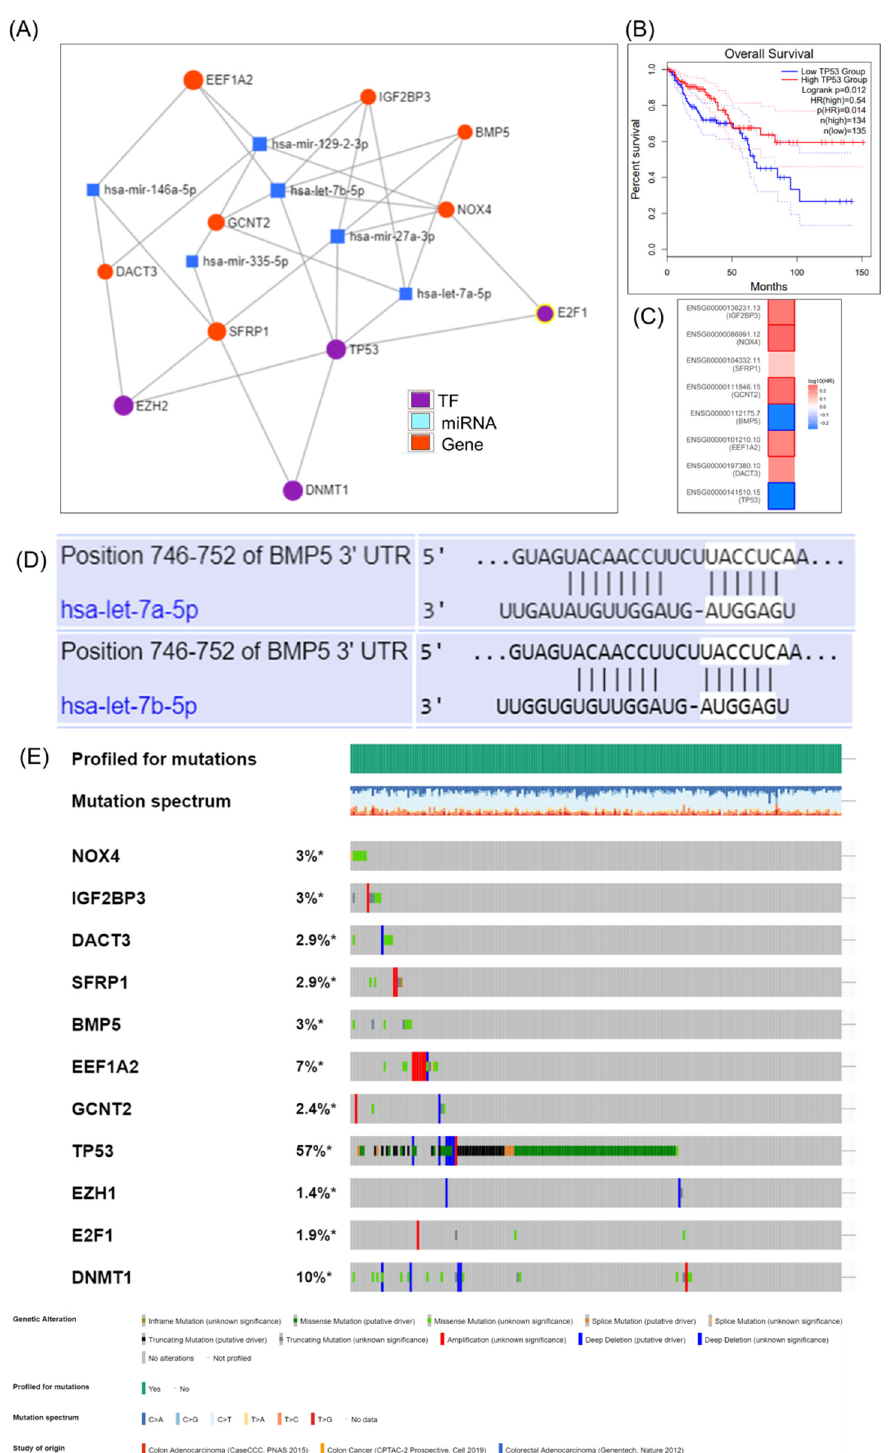
Figure 5. The target gene–miRNA interaction in COAD as revealed by the use of miRNET miRNA target gene online tool. ( A ) Interconnection between the EMT genes, key transcription factors and miRNA, generated using miRNET; ( B ) TP53 predicts overall survival rate in COAD; ( C ) survival map generated using GEPIA online tool; ( D ) prediction of has-let-7a-5p and let-7b-5p binding to BMP5 3 ′ UTRs, generated using TargetScan 3.0 (http://www.targetscan.org/mamm_30/docs/help.html, accessed on 22 April 2021); ( E ) analysis of genetic alterations in COAD using cBioPortal data; online plot presents the mutation frequency for the selected genes found in RNAseq data. * Not Appliable.